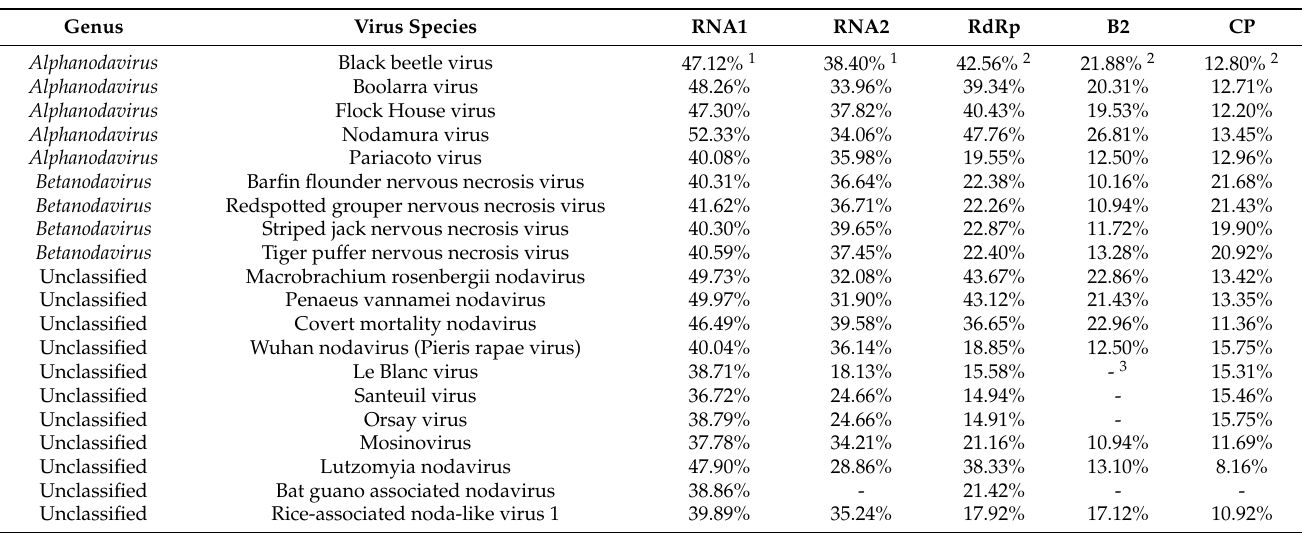
Table 4. Sequence homologies between RNLV2 genomic RNAs, proteins and that of other